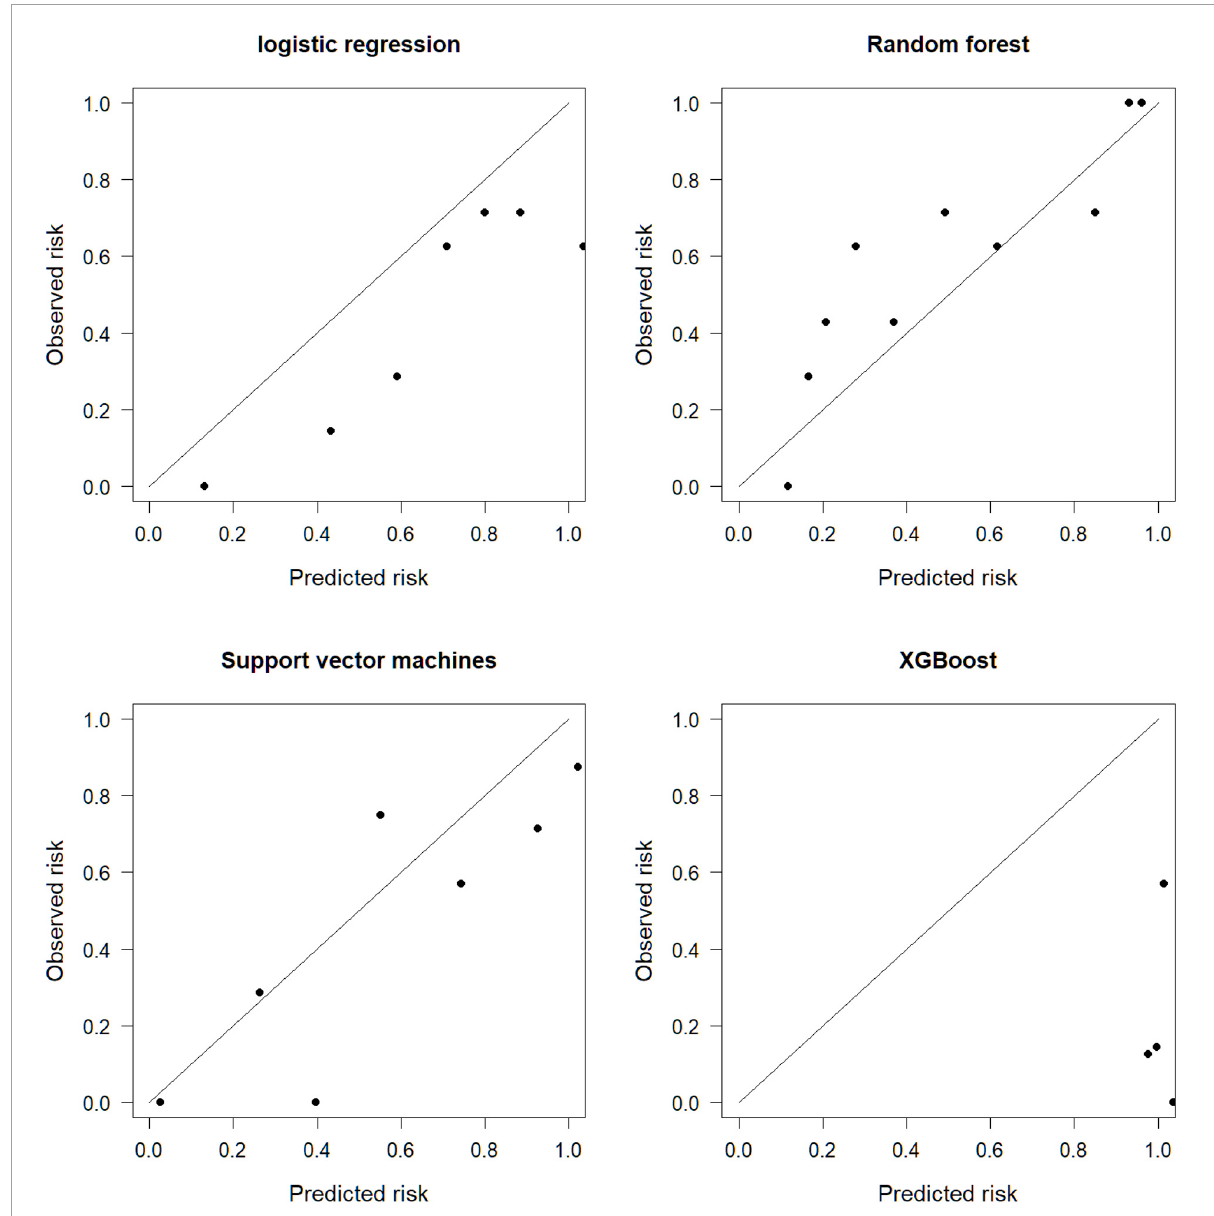
FIGURE3 Calibration diagram.